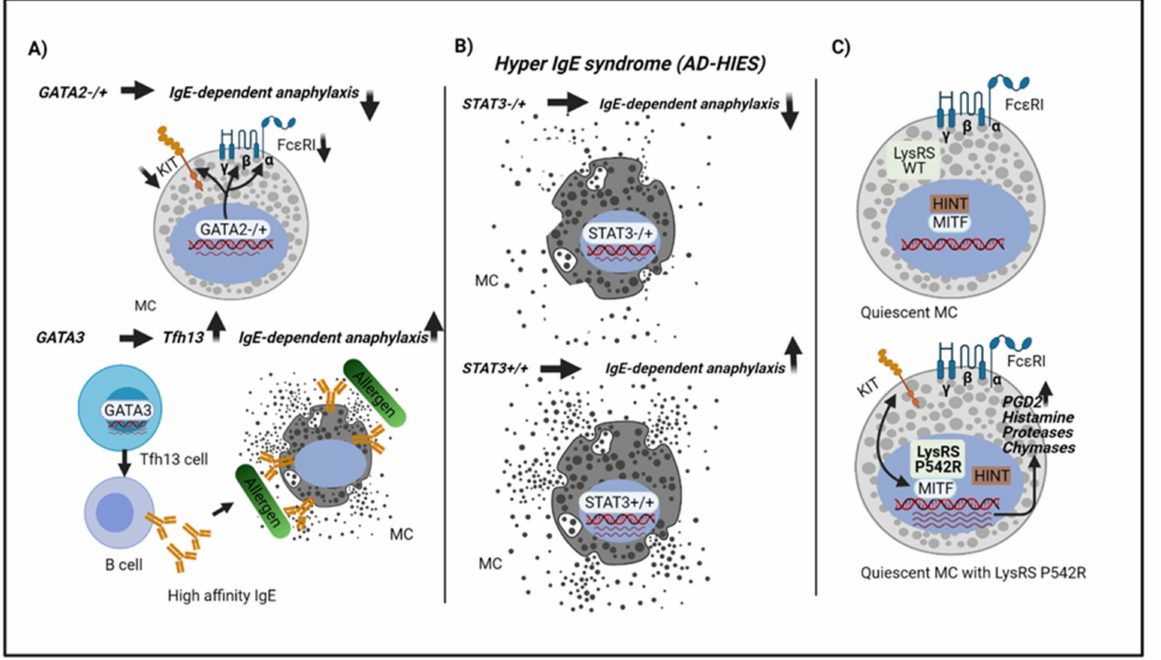
Figure 2. Host factors or mutations related to transcription factors in anaphylaxis. ( A ) Loss of GATA2 function in human subjects result in lower KIT and Fc ε RI expression and IgE-dependent degranulation impaired [53]. GATA3 is essential for Tfh13 cell production, which regulates B cells to produce anaphylactic IgE [59]. ( B ) Loss of STAT3 function in autosomal dominant-hyper IgE syndrome (AD-HIES) shows a decrease in anaphylaxis compared to normal STAT3 activity [77]. ( C ) LysRS P542R induces a conformational change in LysRS allowing translocation into the nucleus, activating MITF, and relative targets genes in the absence of stimuli (quiescent cells). Eventually, the allergen encounter leads to anaphylaxis